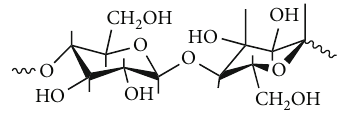
Figure 8: Chemical structure of cellulose.